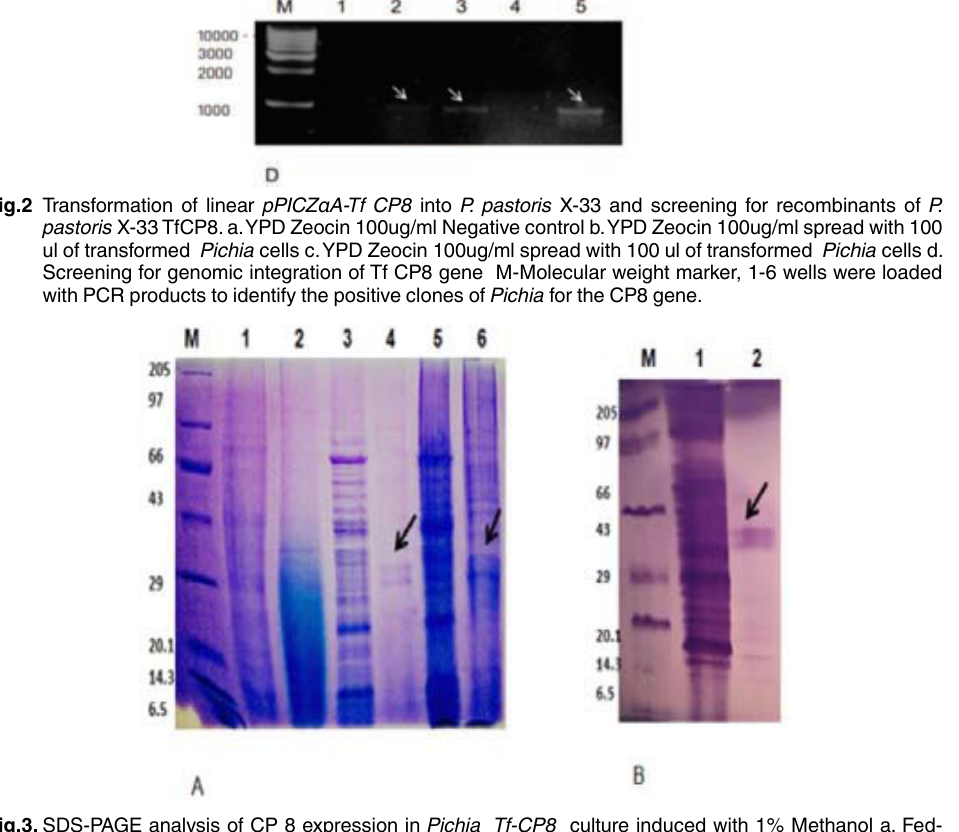
Fig.3. SDS-PAGE analysis of CP 8 expression in Pichia Tf-CP8 culture induced with 1% Methanol a. Fed- batch culture: M-Protein molecular weight marker, 1- Uninduced cell lysate, 2. Uninduced Media,3. 1% methanol induced – 24h Cell lysate, 4. 1% methanol induced –Day 24h media, 5. 1% methanol induced –48 h Cell lysate, 6. 1% methanol induced – 48h media b. Batch culture: M-Protein molecular weight marker,1- 1% methanol induced – 24h Cell